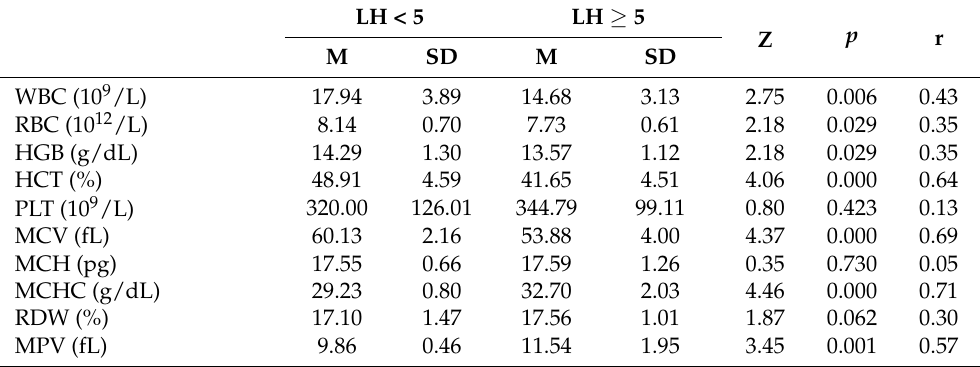
Table 4. Effect of luteinizing hormone level (mlU/mL) on selected haematological and biochemical blood parameters of